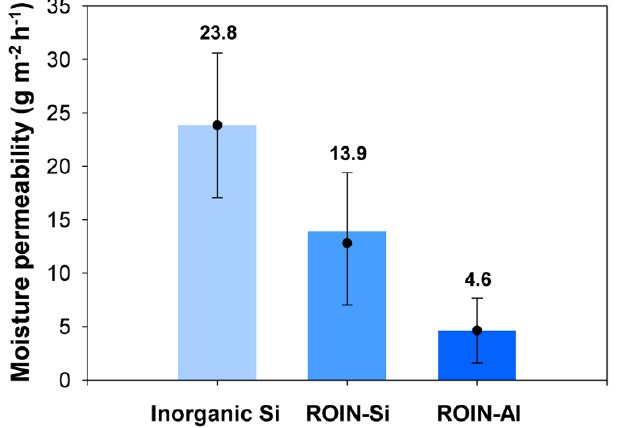
Figure 10. Moisture permeability of the epoxy–acrylate composites containing inorganic silica or reactive hybrid nanoparticles.